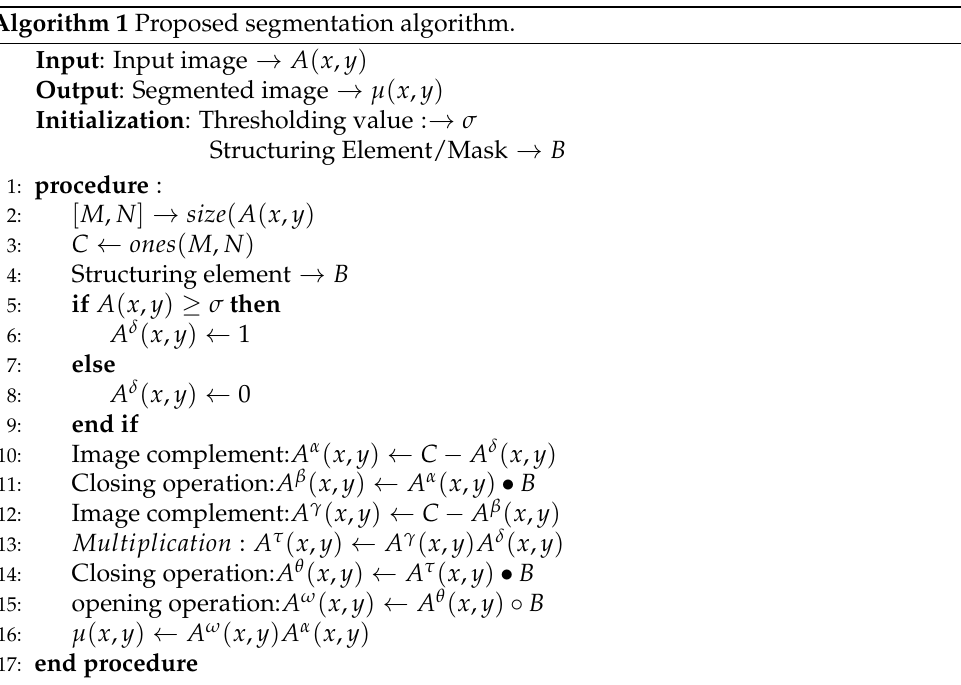
Algorithm 1 Proposed segmentation